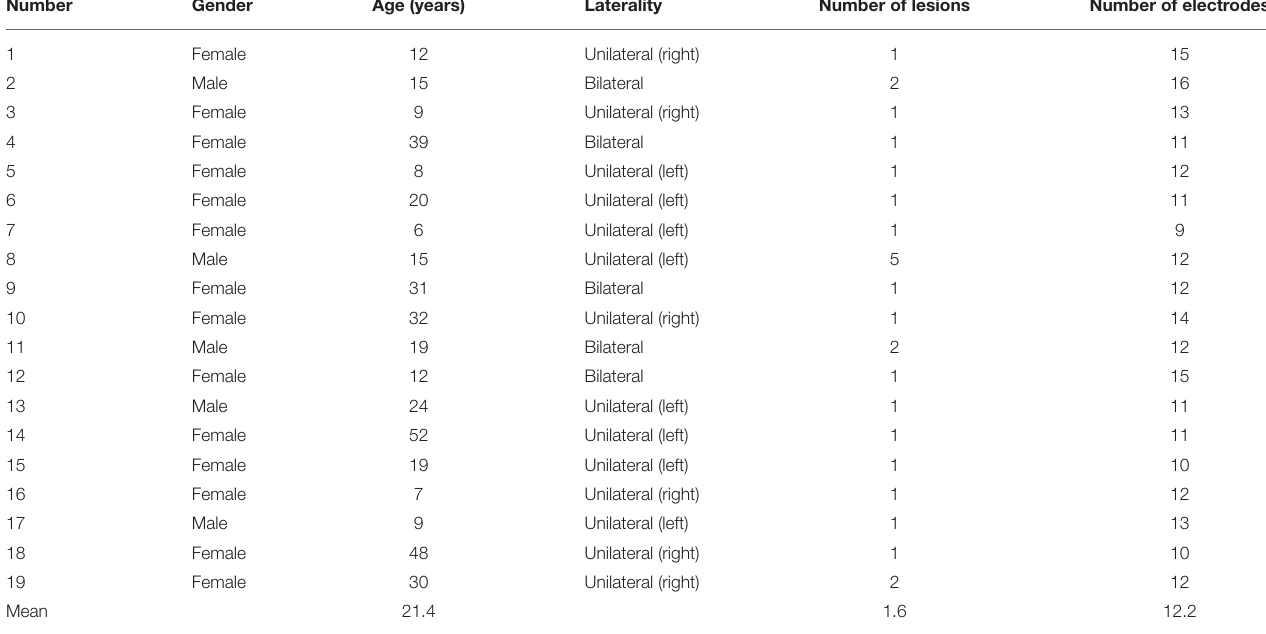
TABLE 1 | Demographics and results of the implantation procedure for each study participant.